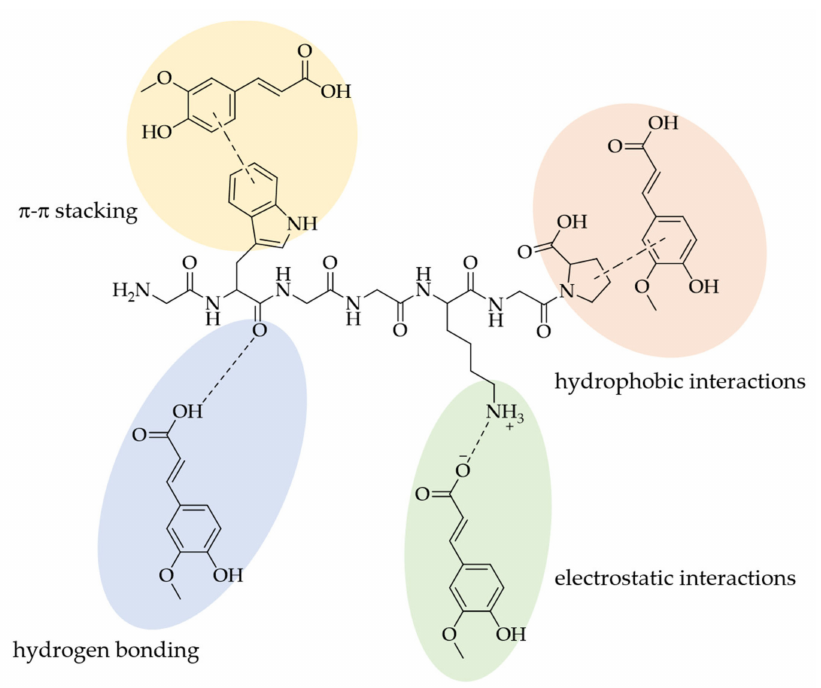
Figure 6. Possible non-covalent interactions between proteins and FA (as an example for almost all